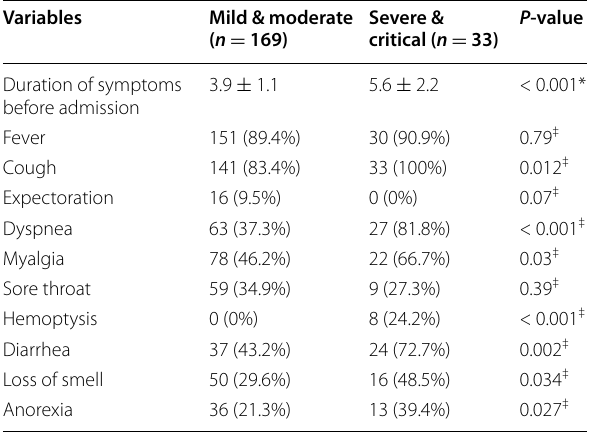
Continuous data represented as mean and SD, and categorical data represented as number and percentage (%).*Independent samples Student’s t -test; ‡ chi- square test; P < 0.05 is